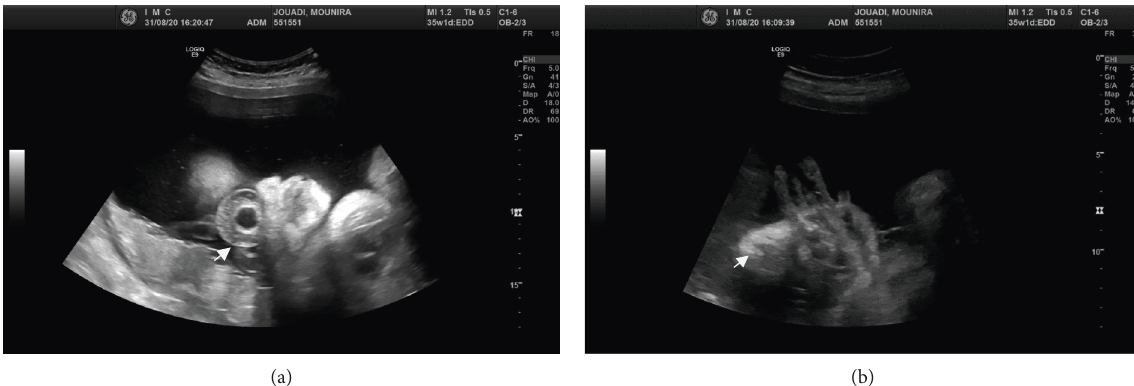
Figure 1: (a) Arrow indicates subluxation and proptosis of the right eye. (b) Arrow indicates deviated broad thumb.